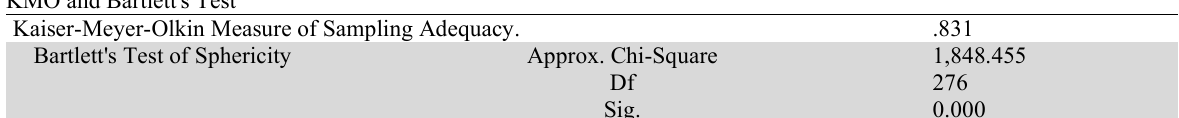
Regression Model Analysis